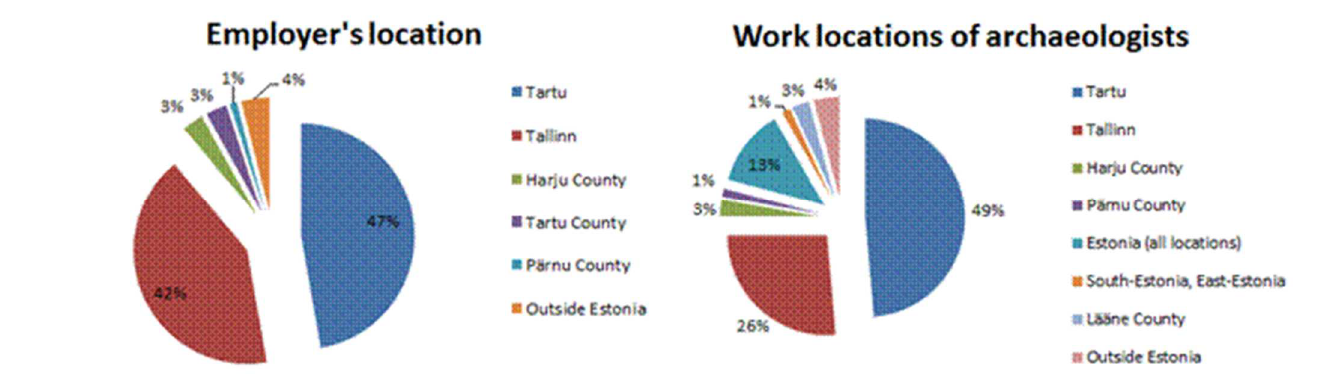
Figure 5 - The geographical location of employers and locations of